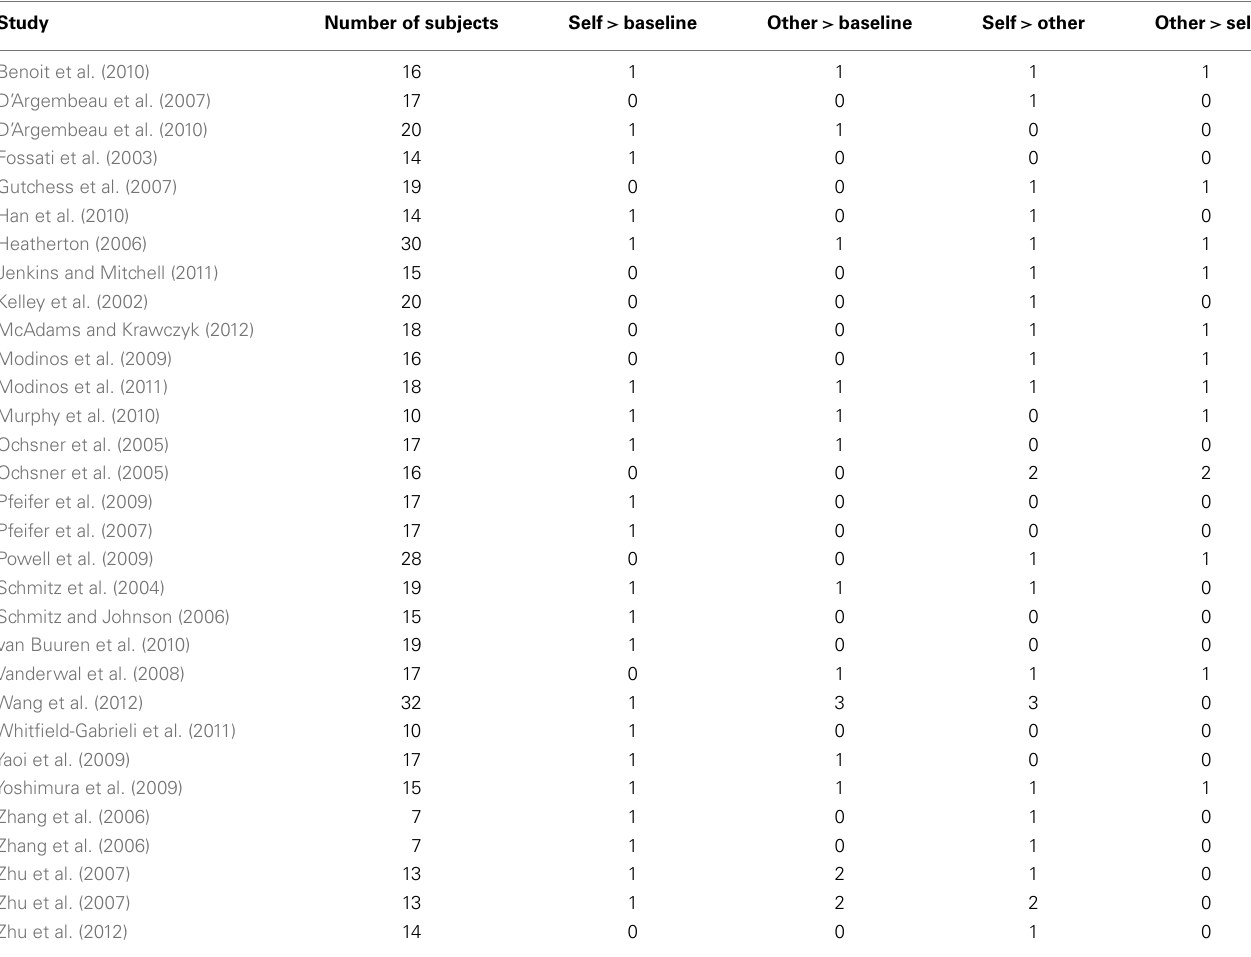
Table 1 | Individual experiments included in the